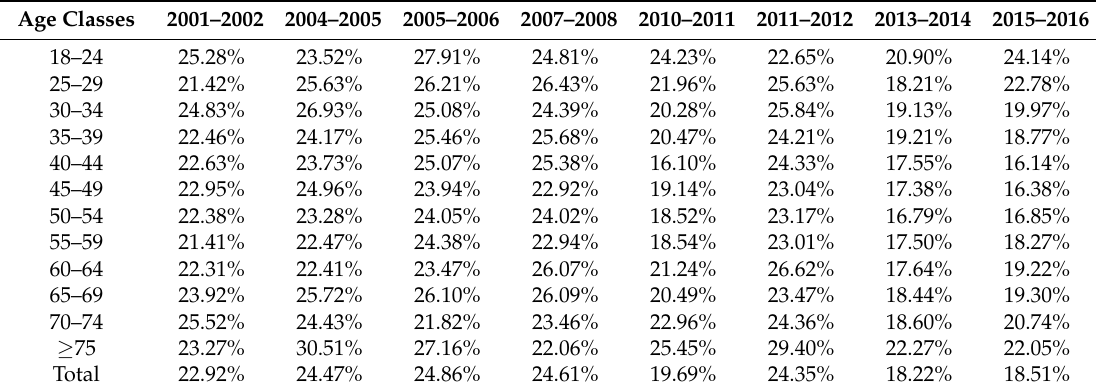
Table 4. Percentage of Energy Consumption Share (>10%) by Household Head’s Age Class.